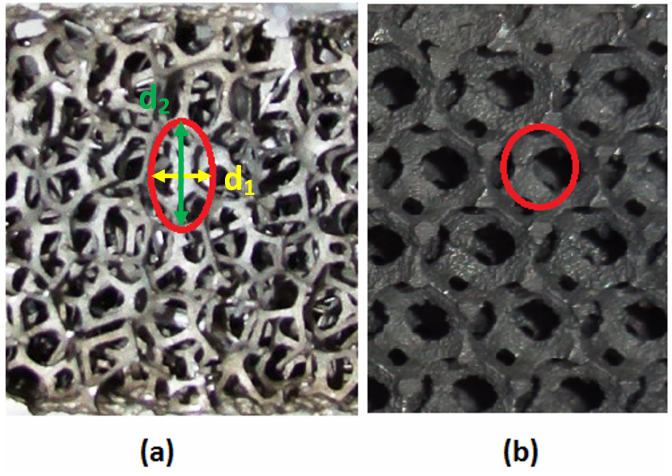
Figure 3. Two cast types of open-cell metal foam produced by ( a ) investment casting from a polyurethane perform and ( b ) leachable bed casting (example from Alveotec, painted black to increase